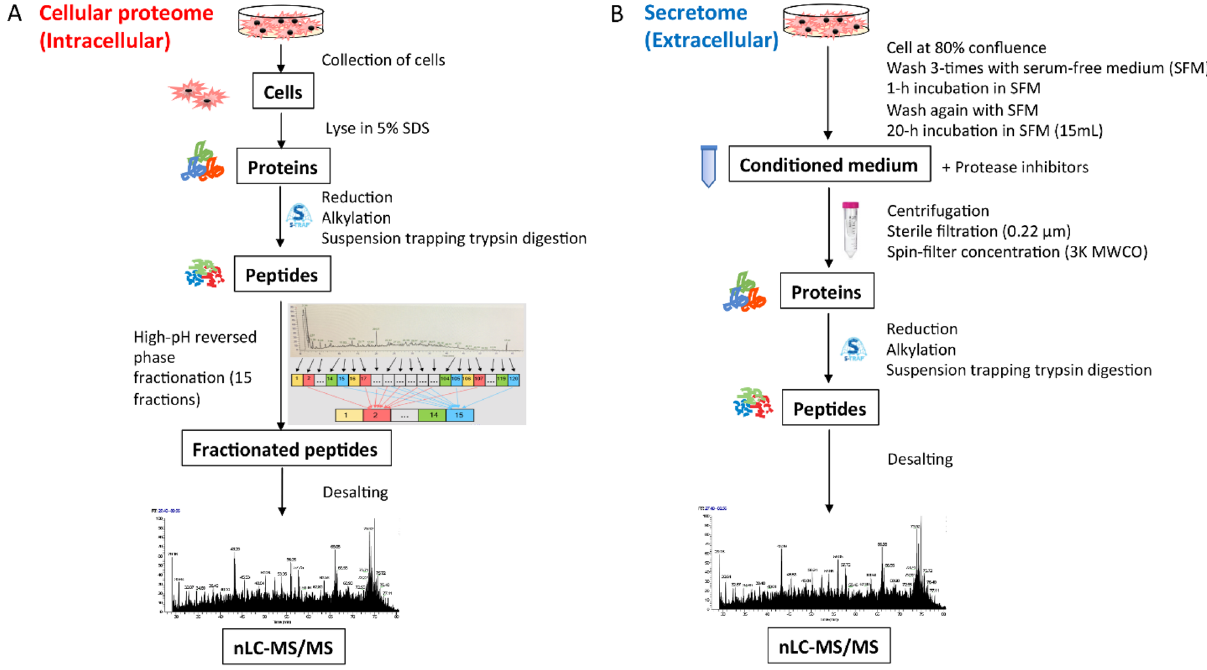
Figure 1. Schematic workflow for the quantification of cellular proteome ( A ) and secretome ( B